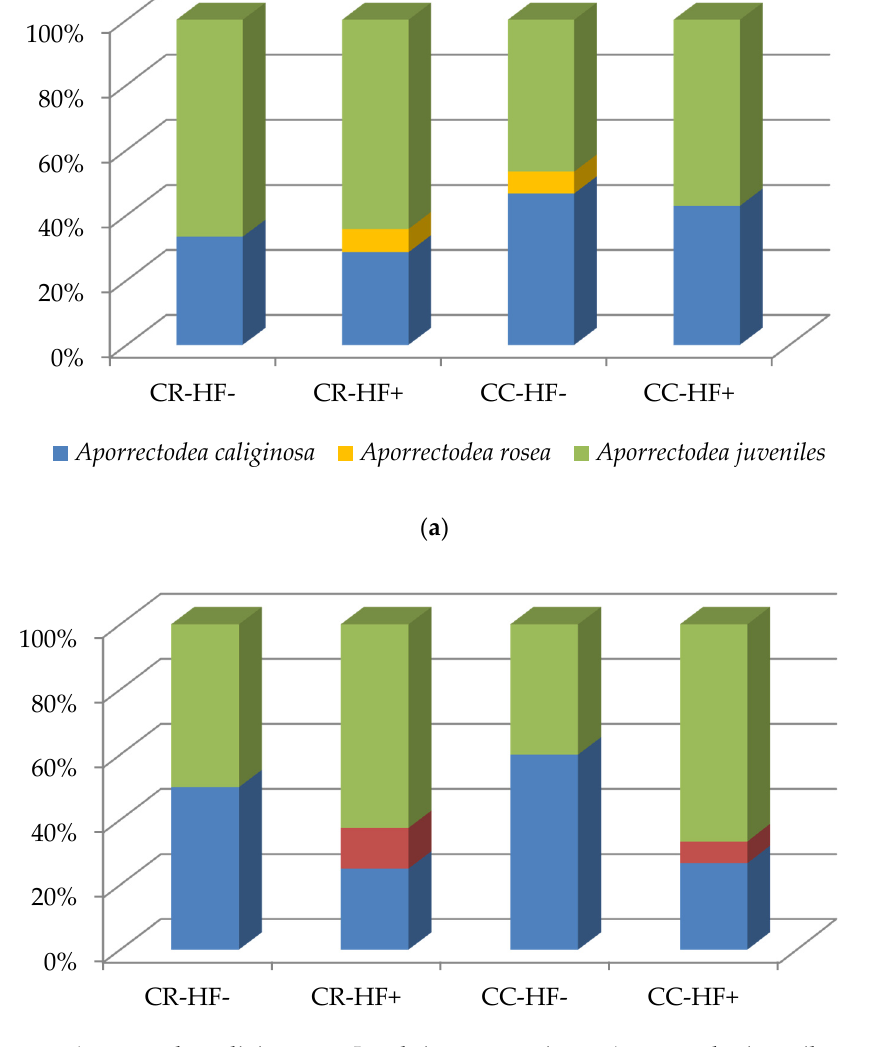
Figure 2. Relative abundance (%) of earthworm species (based on individuals m − 2 ) on ( a ) spring barley and ( b ) faba bean (B) fields; CR—crop rotation, CC—continuous cropping, HF − —no plant protection, HF+—herbicide + fungicide.